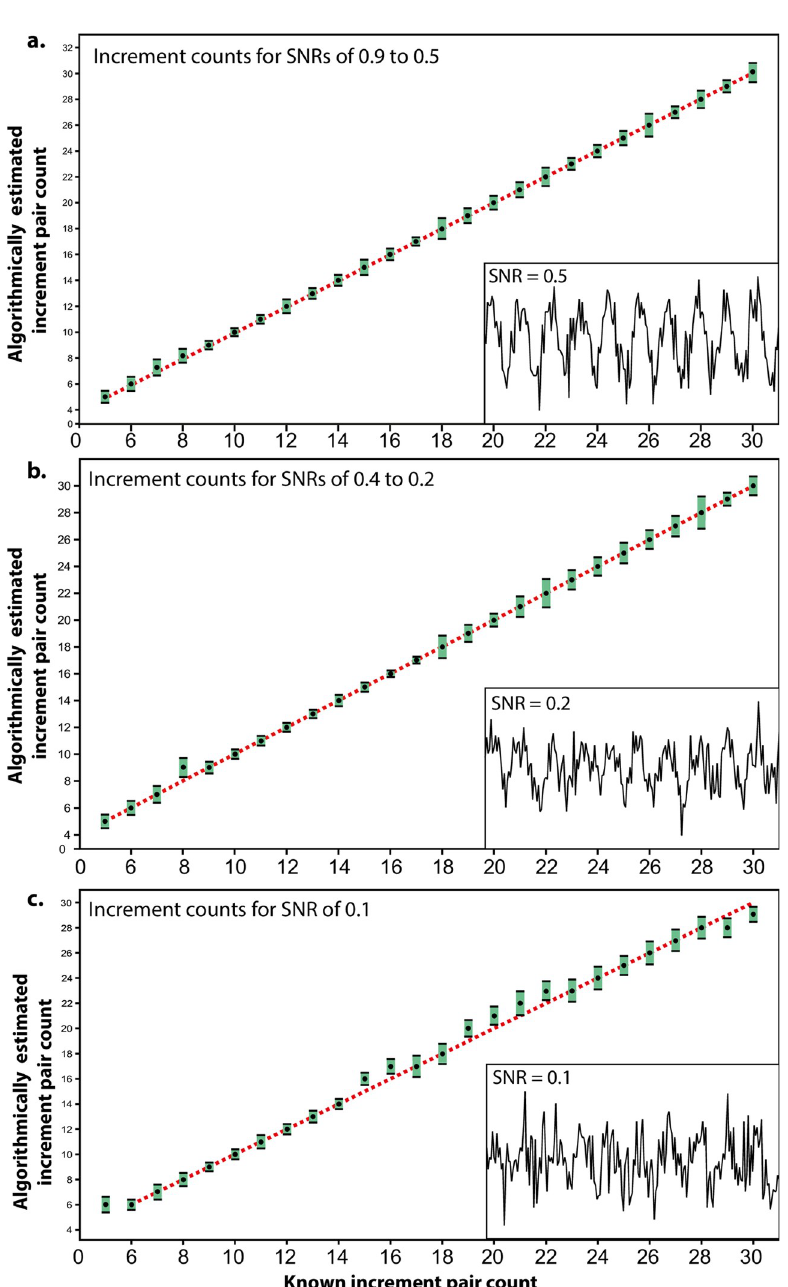
Fig 6. Robustness tests for algorithmic increment counts. ( a ) Counts (black circles) and their standard deviations (green boxes) for incremental sine wave patterns of 5 up to 30 increments with signal-to-noise ratios (SNRs) of 0.9–0.5. Inset: box displaying an example of a 10-increment pattern with an SNR of 0.5. ( b ) Counts and their standard deviations for incremental sine wave patterns of 5 up to 30 increments with SNRs of 0.4–0.2. Inset; box displaying an example of a 10-increment pattern with an SNR of 0.2. ( c ) Counts and their standard deviations for incremental sine wave patterns of 5 up to 30 increments with an SNR of 0.1. Inset: box displaying an example of a 10-increment pattern with an SNR of 0.1. Red dashed lines represent 1:1 correlation between estimated and known increment count. rounded to the nearest integer was defined as the estimated increment pair count for that Macaca mulatta individual.